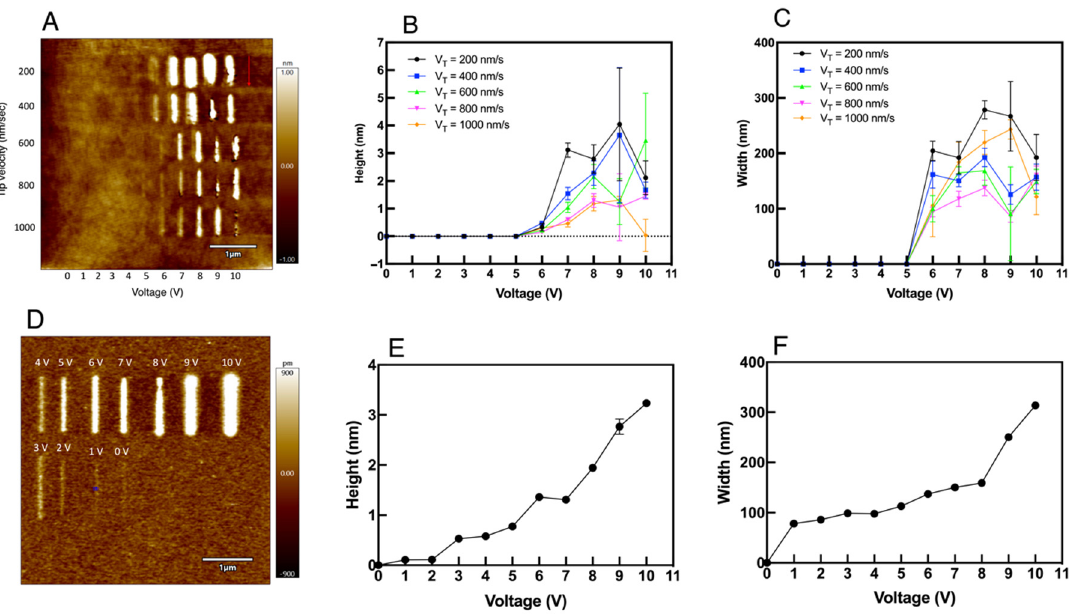
Figure 3. The lines drawn on the surface under different humidity conditions: ( A ) The formation of oxide deposits with different tip velocity and voltage ( B ) The height vs. tip bias and ( C ) Width vs. tip bias of the lines scratched on the silicon surface. F T = 0.1 μ N. RH is 36% ( D ) The lithographical lines drawn on the substrate with different voltage with a relative humidity of 75% and V T = 1 µ m/sec. F T = 0.1 μ N ( E ) The height vs. tip bias and ( F ) width vs. tip bias characteristics.